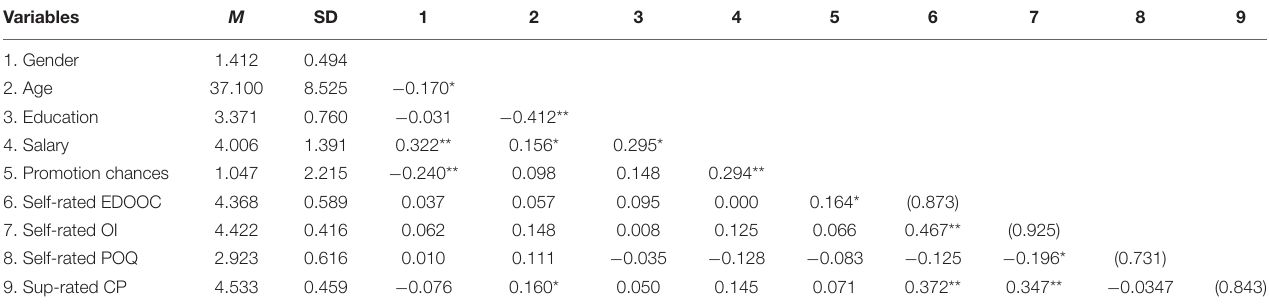
TABLE 1 | Means, standard deviations, and correlations.